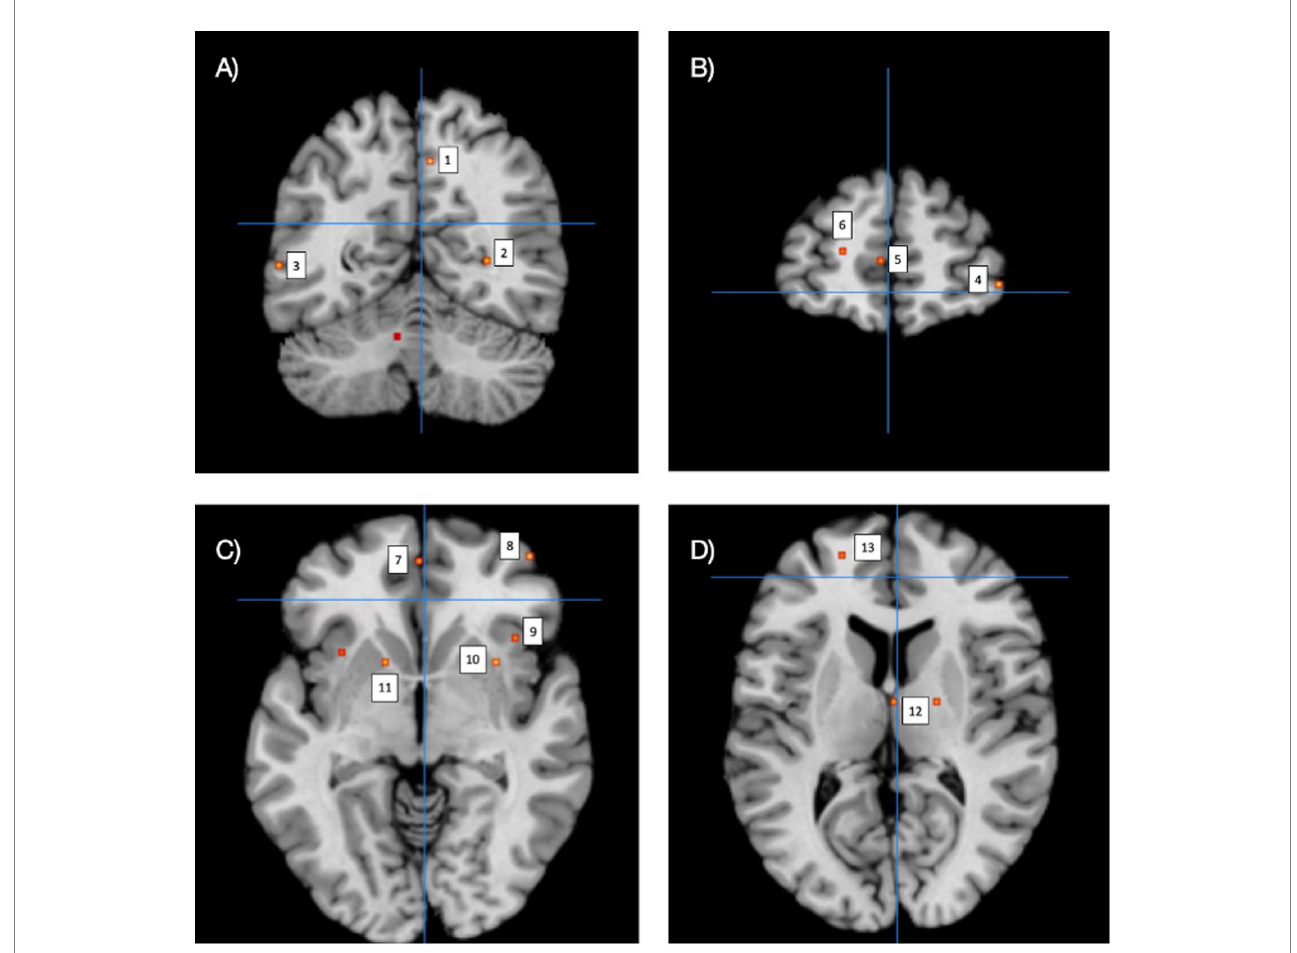
FIGURE 4 Images from ALE meta-analysis. fMR image masks are presented in coronal (A,B) and axial (C,D) positions. Numeration represents registration of significant ROIs as they appear from quadrant A to quadrant D . Significant ROIs (and hemispheres): 1. lingual gyrus (L); 2. precuneus (L); 3. STG (L); 4. IFG (L); 5. MFG (R); 6. SFG (R); 7. ACC (L); 8. IFG (R); 9. insula (R); 10. putamen (R); 11. putamen (L); 12. thalamus (R); 13. SFG (L).